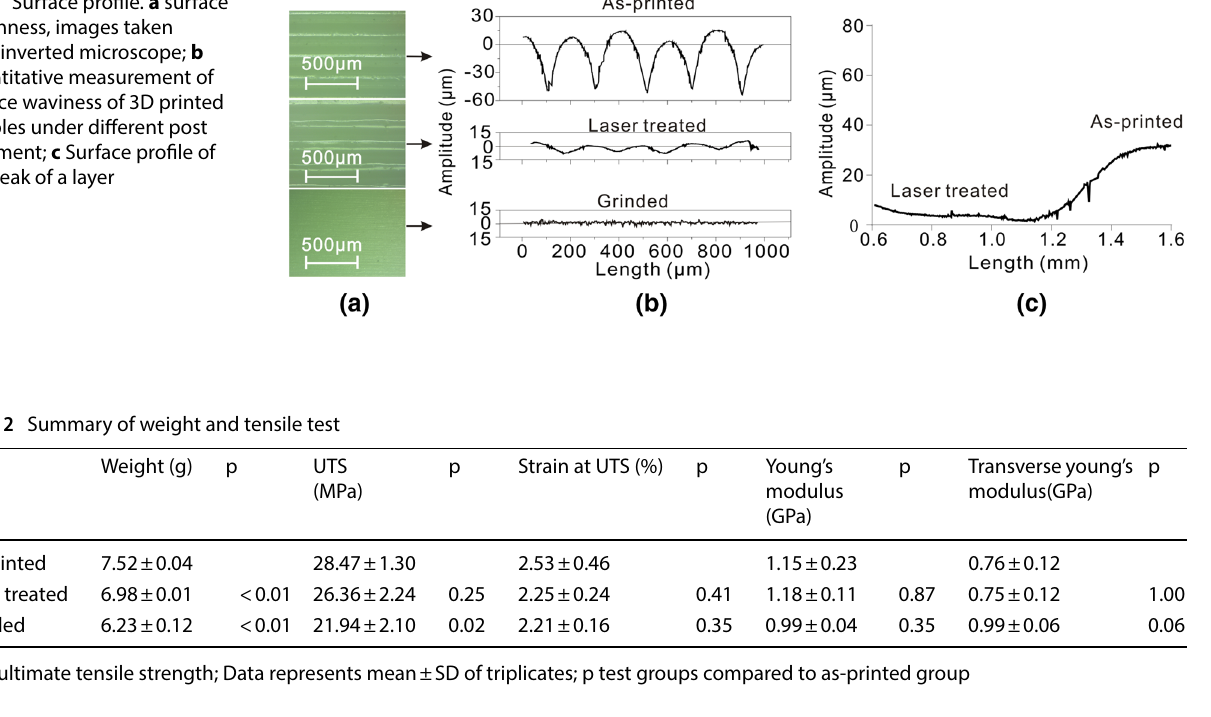
Fig. 3 Tensile test. a Schematic of tensile test; b Stress–strain curves of FDM specimens with different post processing. Grinded samples had lower ultimate tensile stress at all the three repeats; c The experi- mental setup of tensile; d SEM images of the morphologies of the edges at the